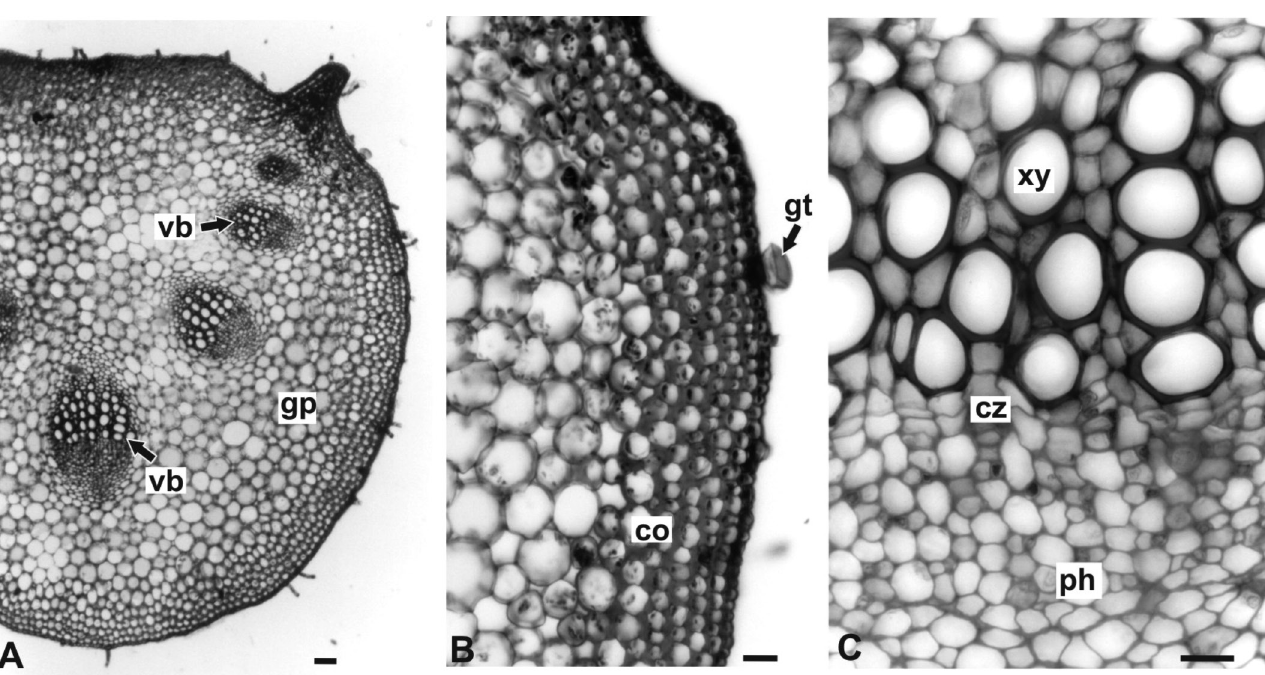
FIGURE 3 - A-C: Gymnanthemum amygdalinum (Delile) Sch.Bip. ex Walp. – petiole, transverse section: A. Overall feature of the petiole; B. Glandular trichome and collenchyma; C. Detail of a collateral vascular bundle. Abbreviations: co – collenchyma, cz – cambial zone, gp – ground parenchyma, gt – glandular trichome, ph – phloem, vb – vascular bundle, xy - xylem. Bar = 100 µm (A), 20 µm (B,